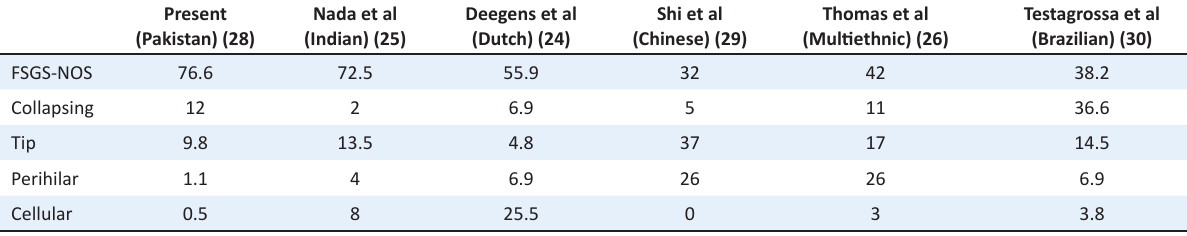
Table 2. Published studies in variants of